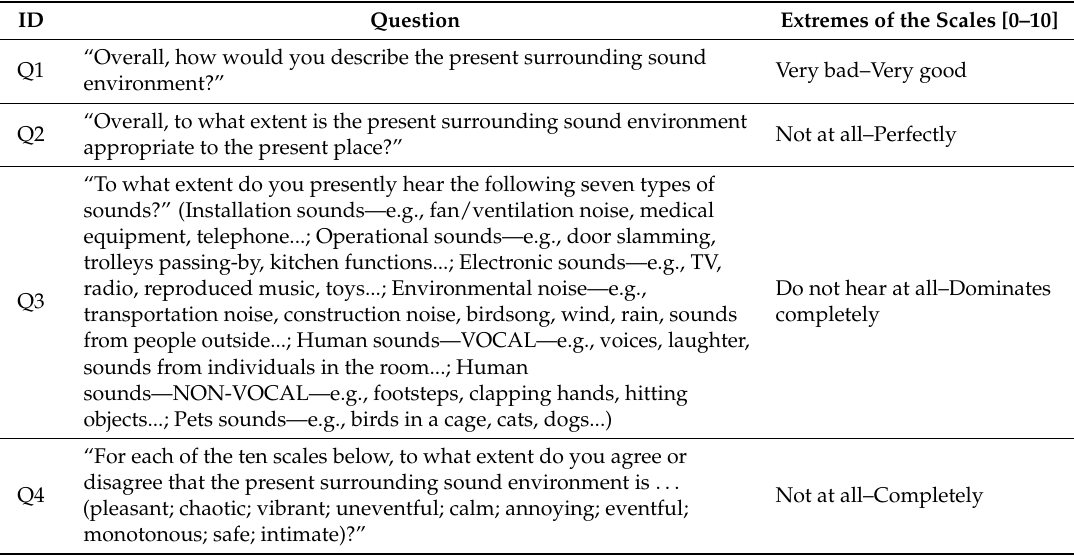
Table 2. Questionnaire used during the soundscape observation in the nursing